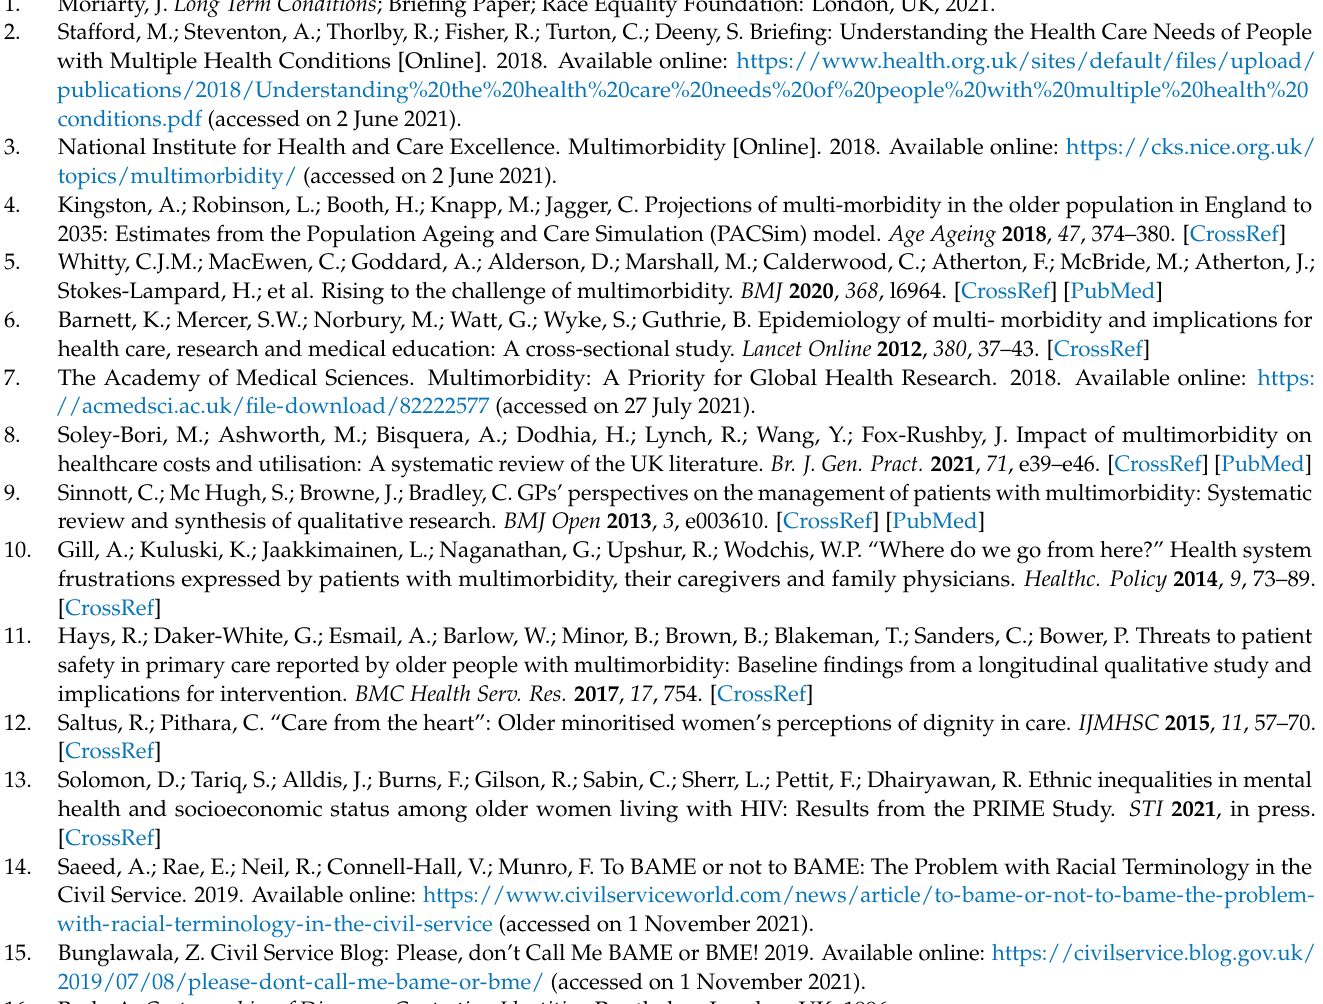
Table A1. Cont . (MAINSUBJECT.EXACT (“England and Wales”) OR MAINSUBJECT.EXACT (“Channel Islands”) OR MAINSUBJECT.EXACT (“UK”) OR MAINSUBJECT.EXACT (“Scotland”) OR 3 Country MAINSUBJECT.EXACT (“England”) OR MAINSUBJECT.EXACT (“Northern Ireland”) OR MAINSUBJECT.EXACT (“Wales”)) OR ti, ab, if (“United Kingdom” OR “UK” OR England OR Wales OR Scotland OR “Northern Ireland” OR Britain OR “Great Britain”) (MAINSUBJECT.EXACT.EXPLODE (“Mixed ethnicity”) OR MAINSUBJECT.EXACT. EXPLODE (“Ethnicity”)) OR ab,ti,if (“Ethnic Group?” OR “african continental ancestry group” OR Arab OR Africa? OR Afro? OR Asian OR “Asian Continental Ancestry Group” OR “Asylum seeker” OR Bangladesh? OR Black OR “BME” OR “BAME” OR Caribbean OR China OR Chinese 2 Ethnicity OR Cultur? OR Divers? OR Ethnic? OR Gypsy OR India? OR Irish OR Migrant OR Minorit? OR